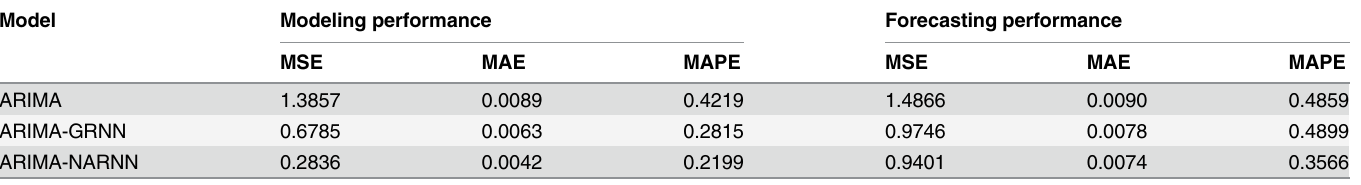
Table 4. Comparison of the modeling and forecasting performance of ARIMA, ARIMA-GRNN and ARIMA-NARNN model.